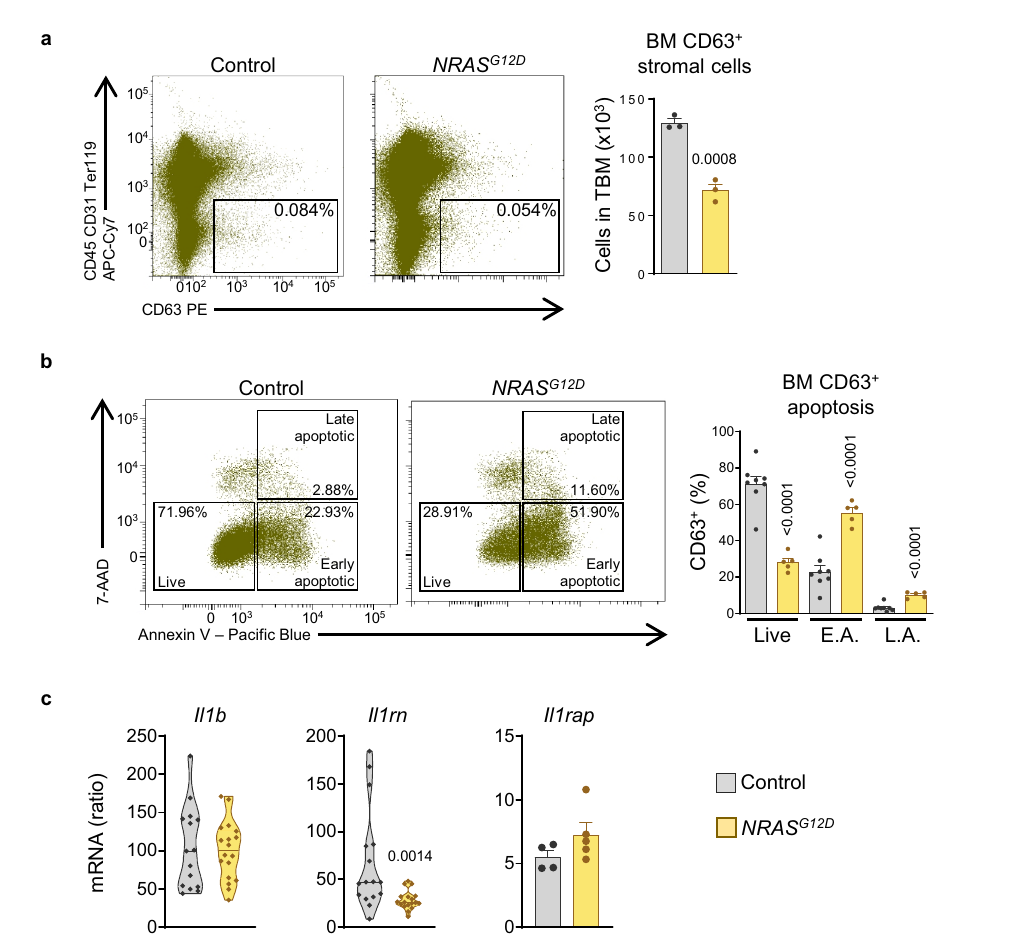
Fig. 9 | Damage to the bone marrow stroma in a mouse model ofpre-leukemic myelopoiesis.a Representative fl uorescence-activatedcellsorting (FACS)analysis (cellsintotalbonemarrow;TBM,%)andTBMnumberofCD45 − CD31 − Ter119 − CD63 + stromalcells from control( Mx1-Cre − NRAS G12D )and NRAS-G12D + ( Mx1-Cre + NRAS G12D ) mice ( n =3 per group). b Representative FACS analysis (cells in BM CD63 +